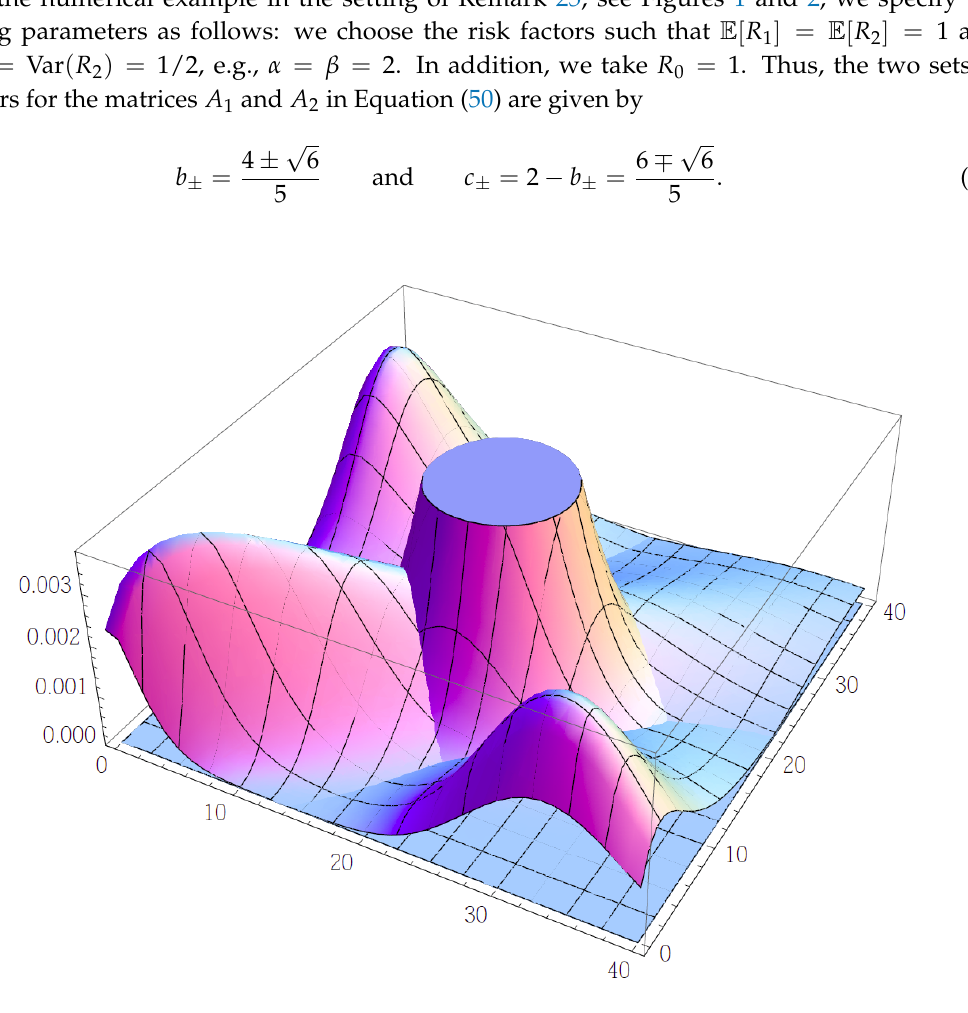
-valued portfolio loss ˆ S corresponding 0 = δ X s = δ ( 1,0 ) and ( 0,1 ) 2 1